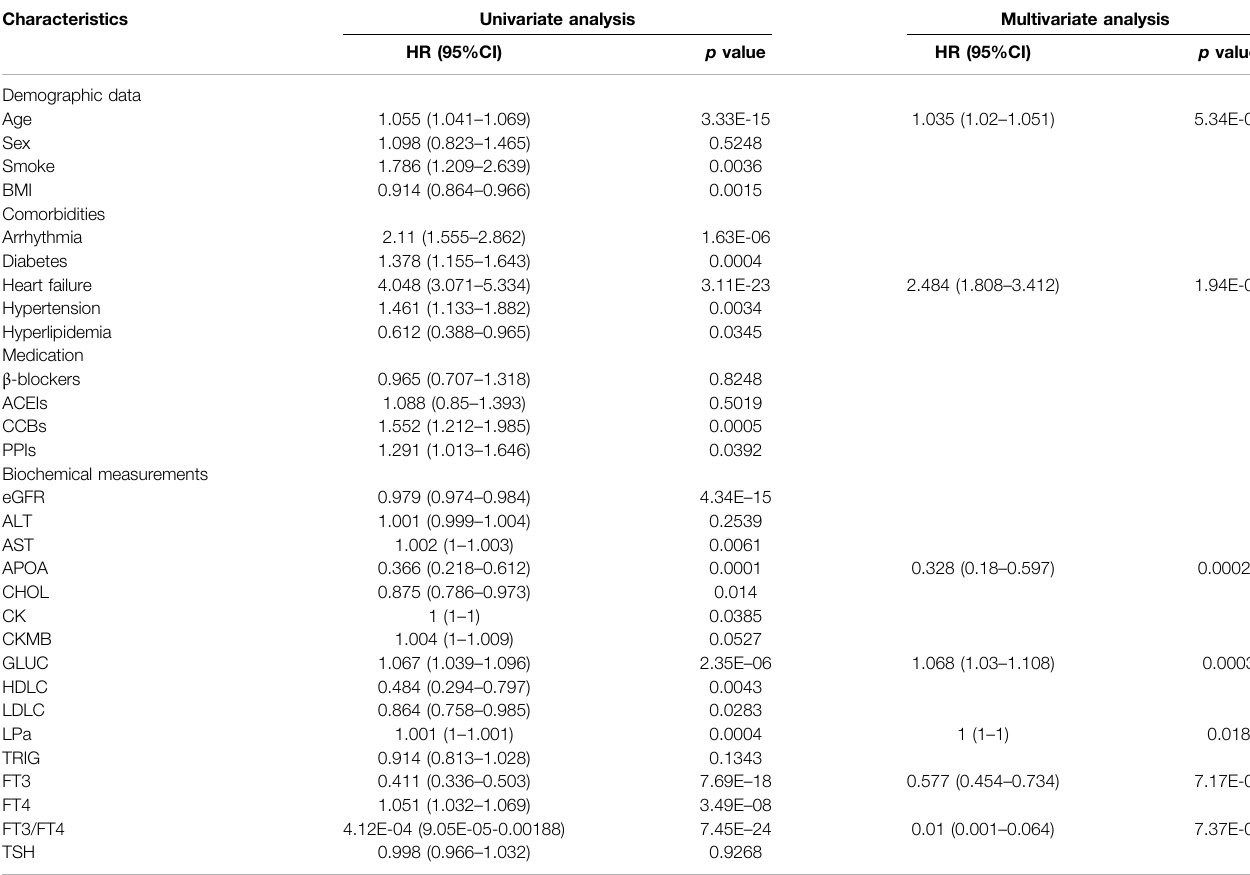
TABLE 2 | Cox proportional hazards analysis for